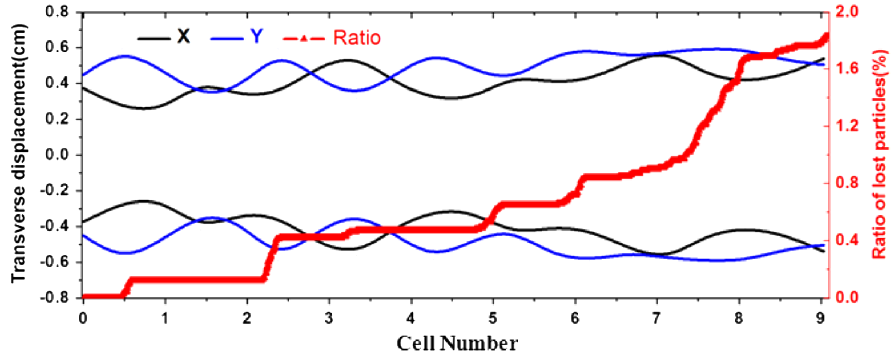
FIG. 13. Ratio of lost particles to total